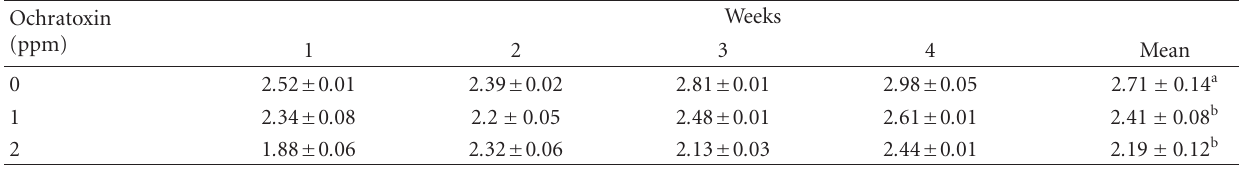
Table 4: Mean ( ± S.E.) serum total protein g/dL values of broiler chickens fed ochratoxin.